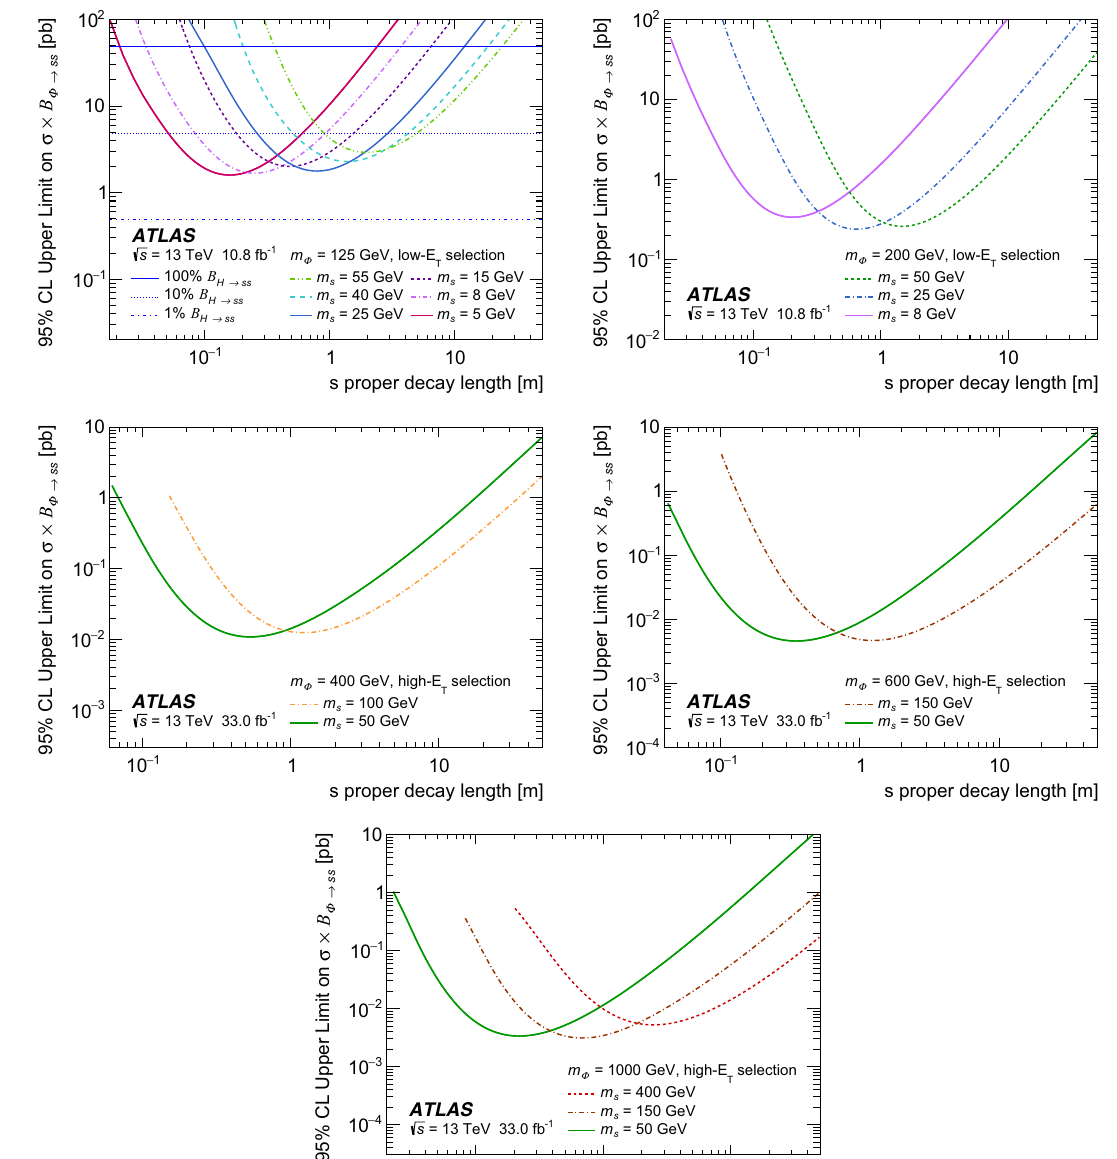
Fig. 9 The observed limits for the (cid:4) masses of 125, 200, 400, 600 and 1000 GeV